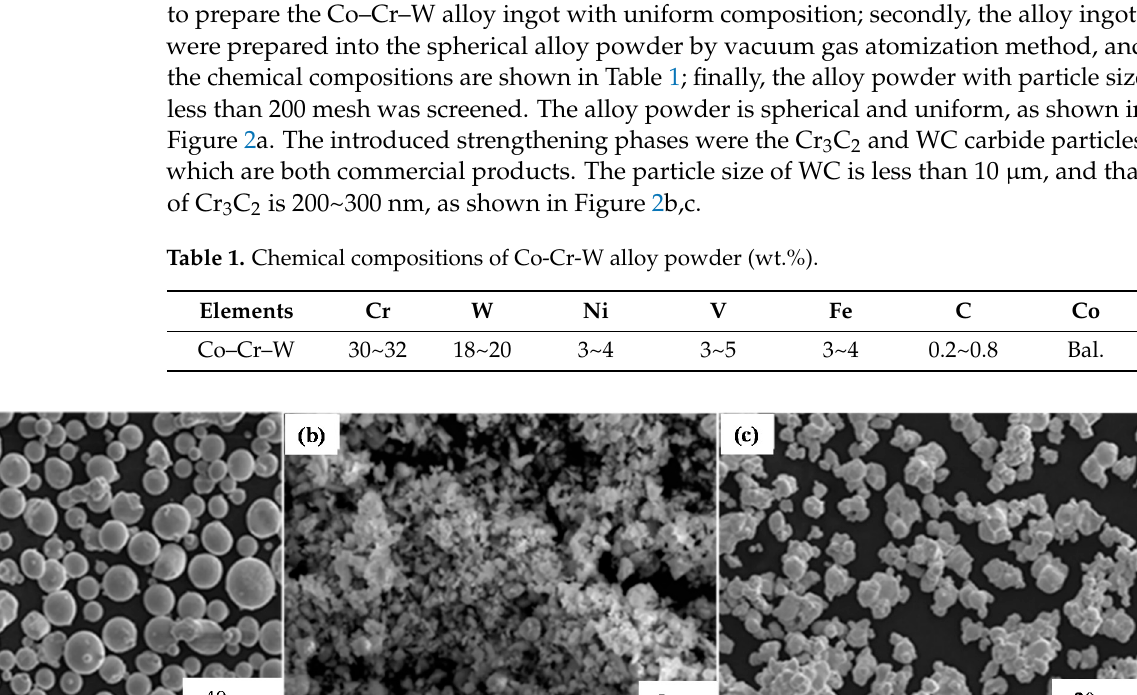
Figure 2. SEM images of Co – Cr – W alloy powder and carbide powder. ( a ) Co – Cr – W alloy powder; ( b ) Cr 3 C 2 powder; ( c ) WC powder. Table 1. Chemical compositions of Co-Cr-W alloy powder (wt.%).